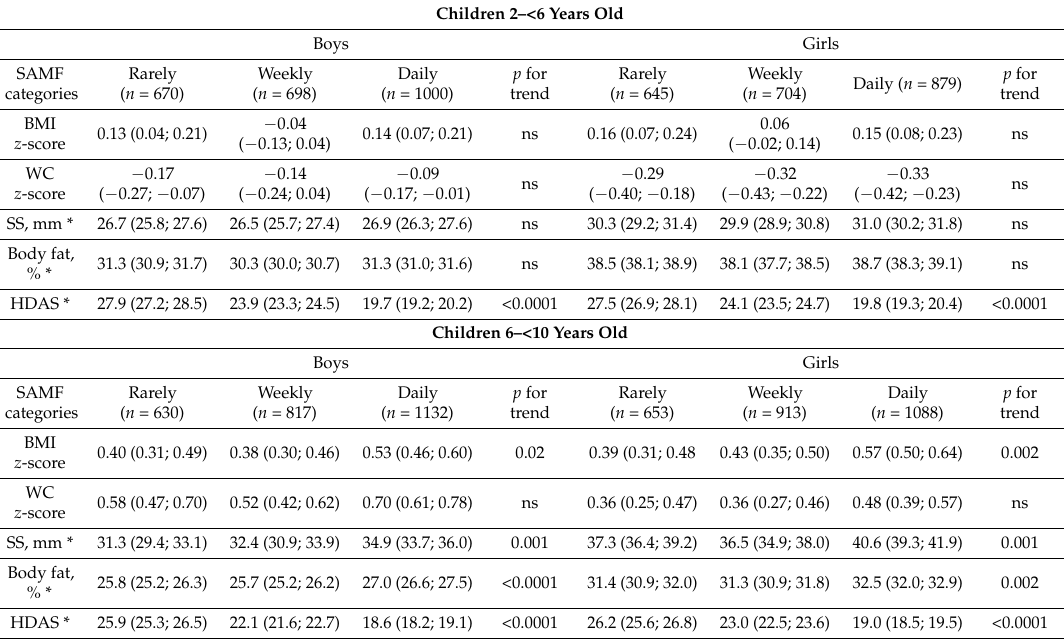
Table 2. Anthropometric variables and Healthy Dietary Adherence Score (HDAS) at baseline across sugars added to milk and/or fruit (SAMF)